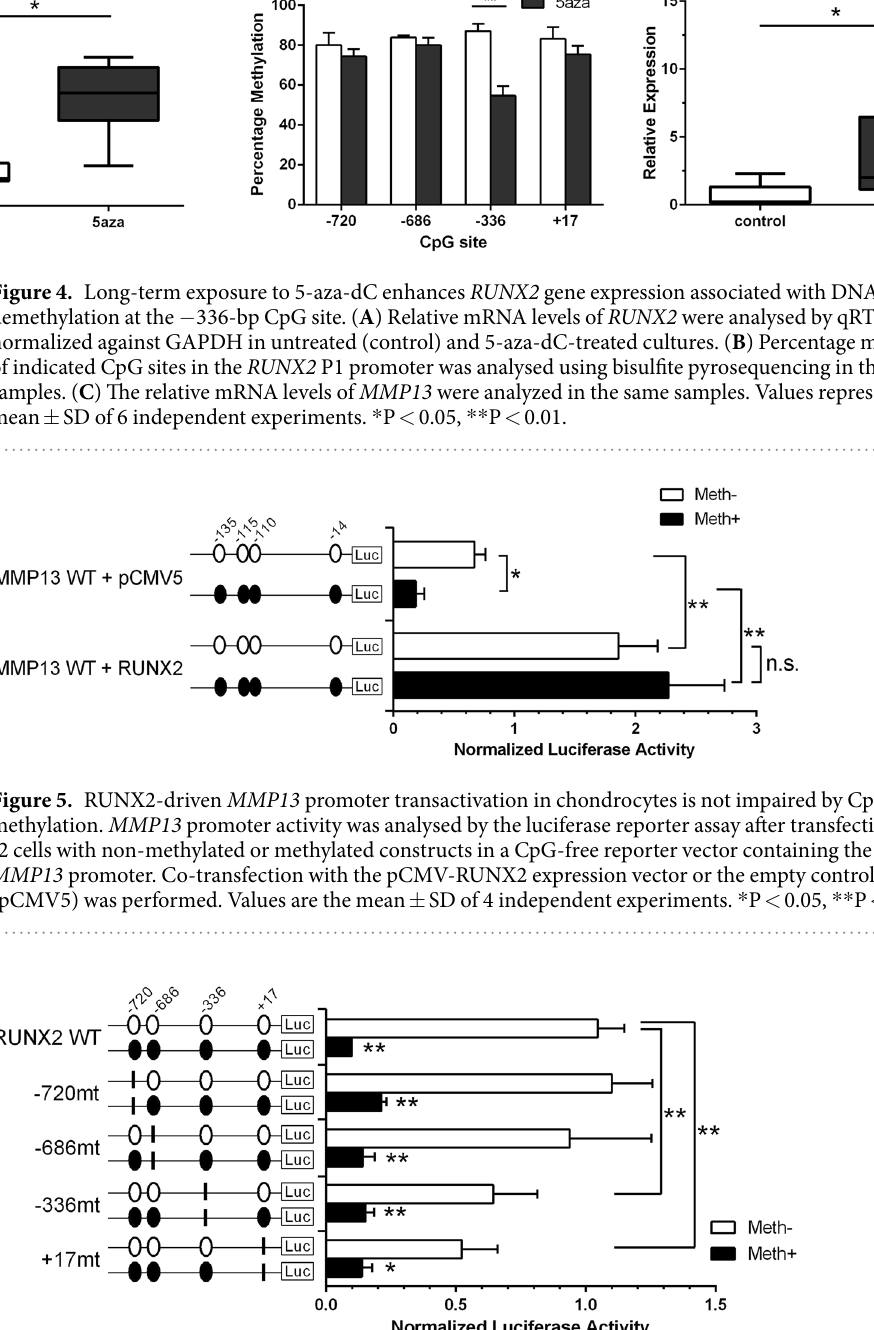
RUNX2 gene expression significantly correlated with MMP13 mRNA levels in clinical OA samples. MMP-13 is a